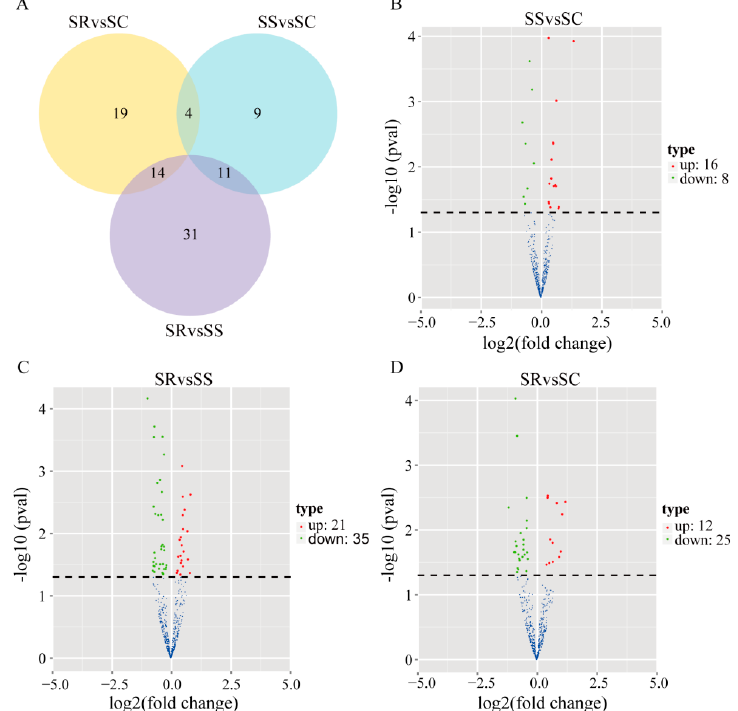
Figure 3. Venn diagram of differentially expressed miRNAs in three comparison groups ( A ). Volcano plot of the differentially expressed miRNAs in SS vs. SC ( B ), SR vs. SS ( C ), and SR vs. SC ( D ).